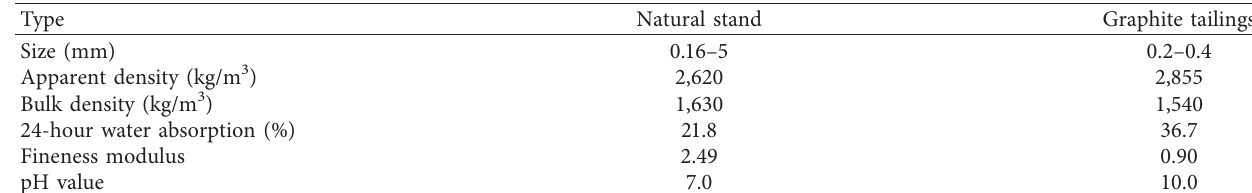
Table 4: Properties of sand and graphite